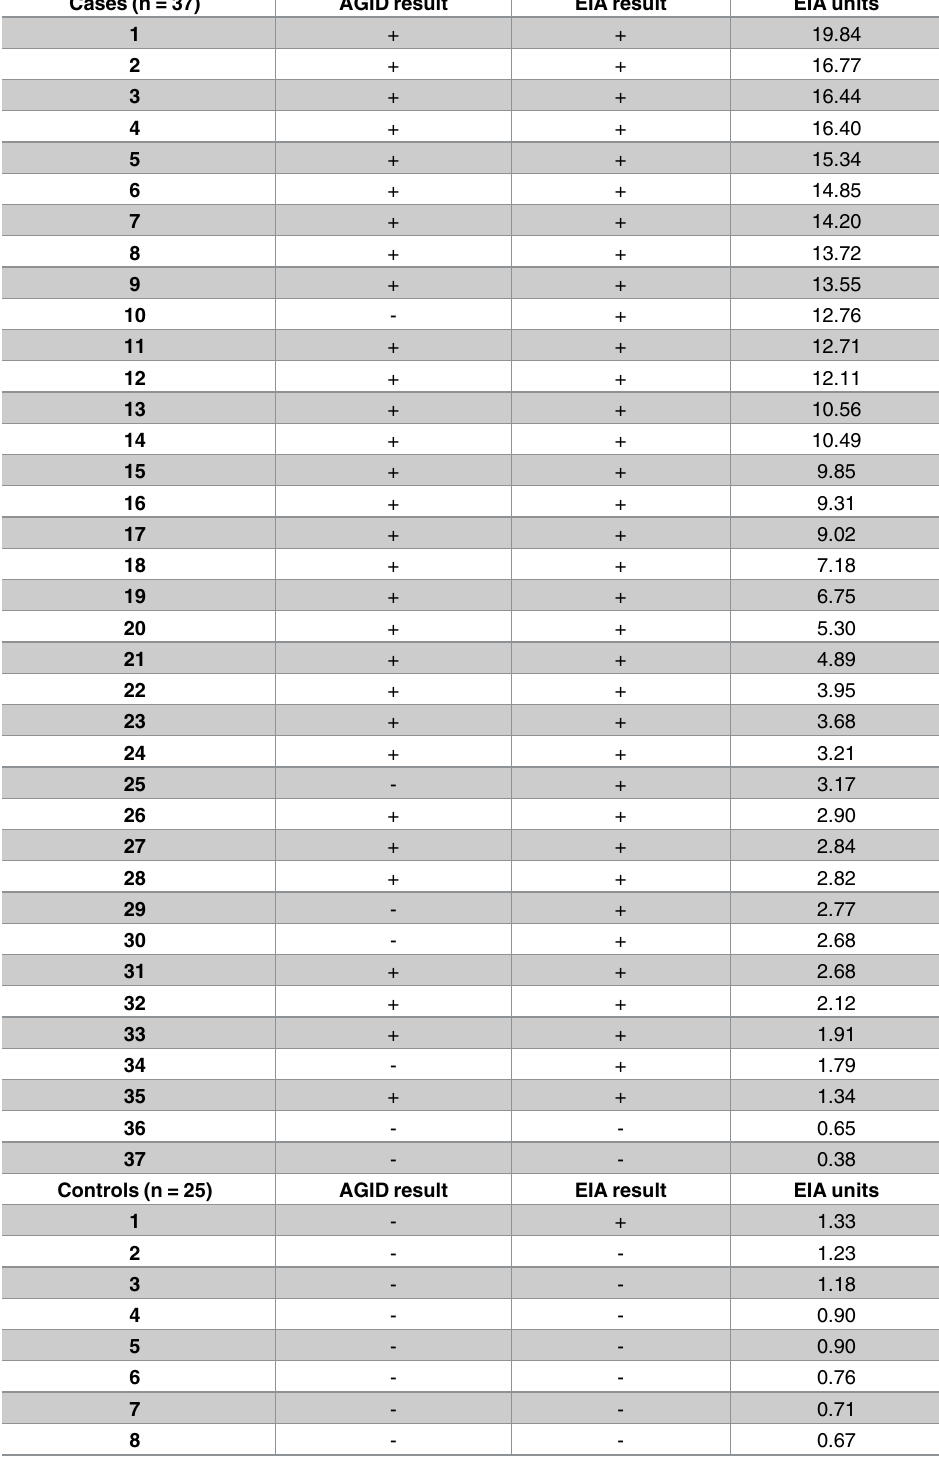
Table 2. Comparison of AGID and EIA results for dog sera from confirmed coccidioidomycosis cases and healthy